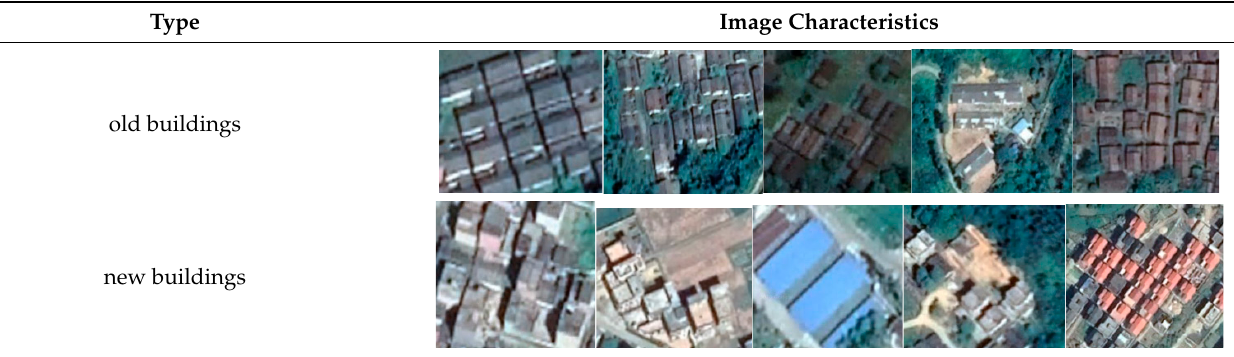
Table 1. The image characteristics of new and old buildings in rural areas.